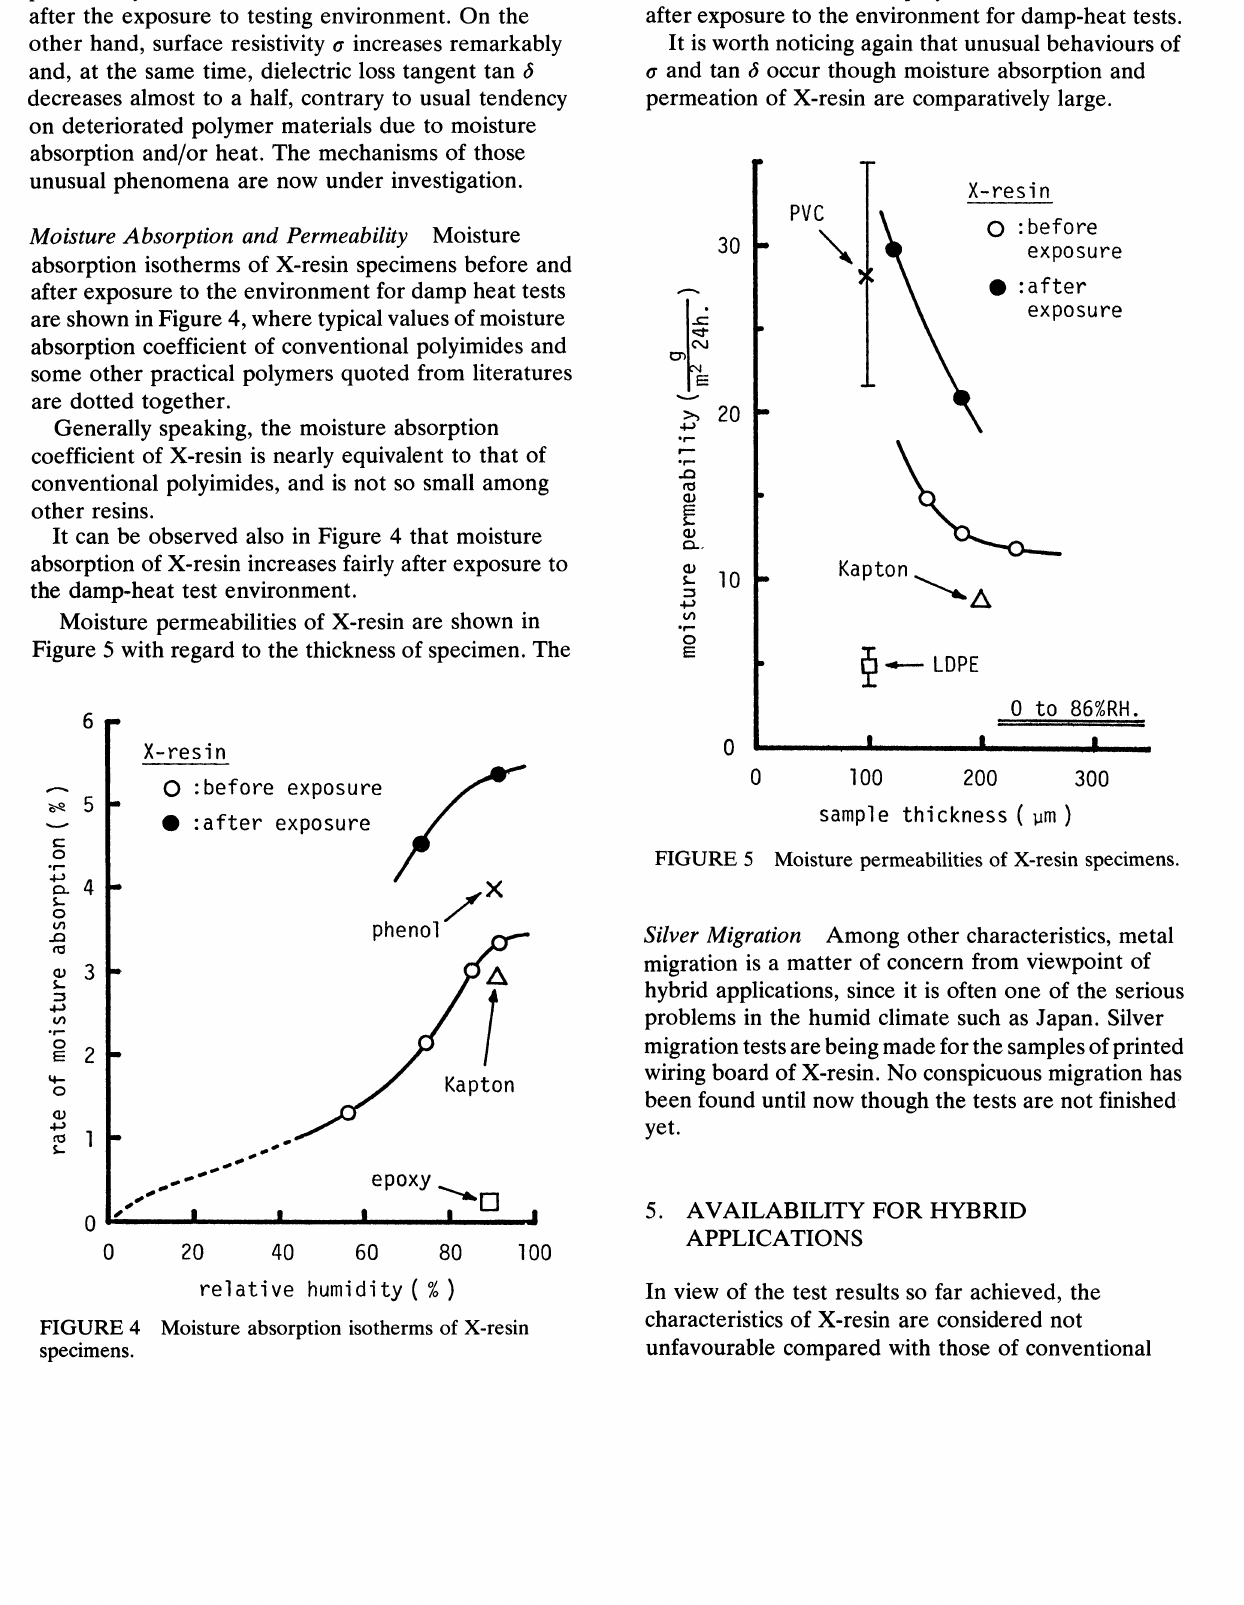
FIGURE 4 Moisture absorption isotherms of X-resin specimens.